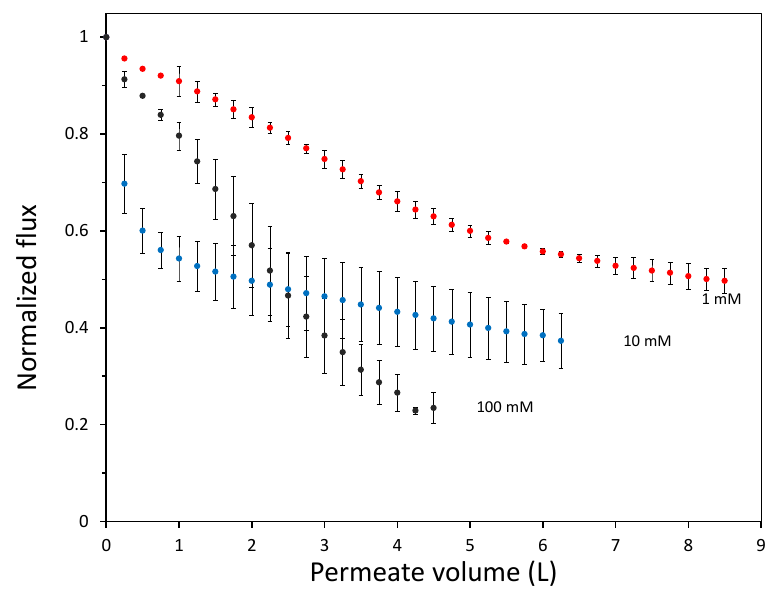
Figure 8. Normalized membrane flux as a function of the permeated volume for different concentrations of NaCl and 463 mg/L SDS. 48 kg/h TMP = 1 bar.